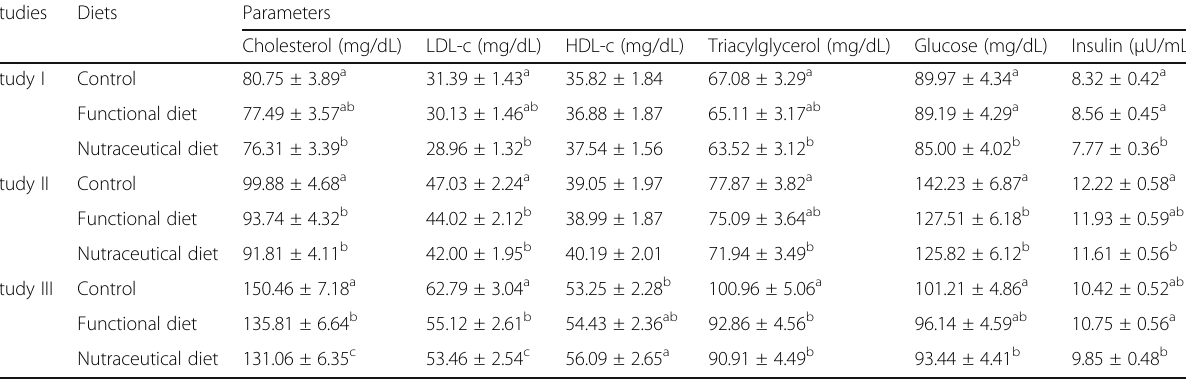
Table 2 Effect of diets on lipidemic and glycemic parameters of rats in different studies